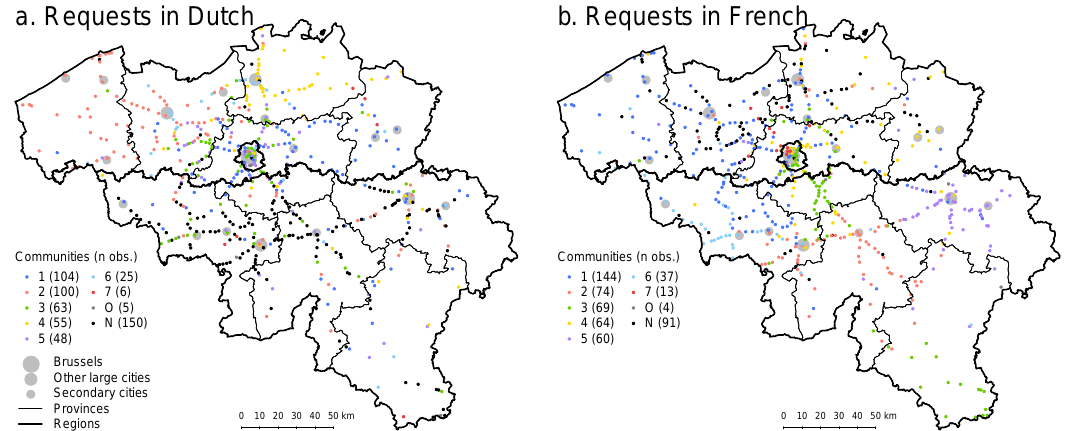
Figure 7. Communities in the iRail dataset for the requests made in ( a ) Dutch and in ( b ) French (in the legend: O = other communities, with less than five nodes; N = not present in the